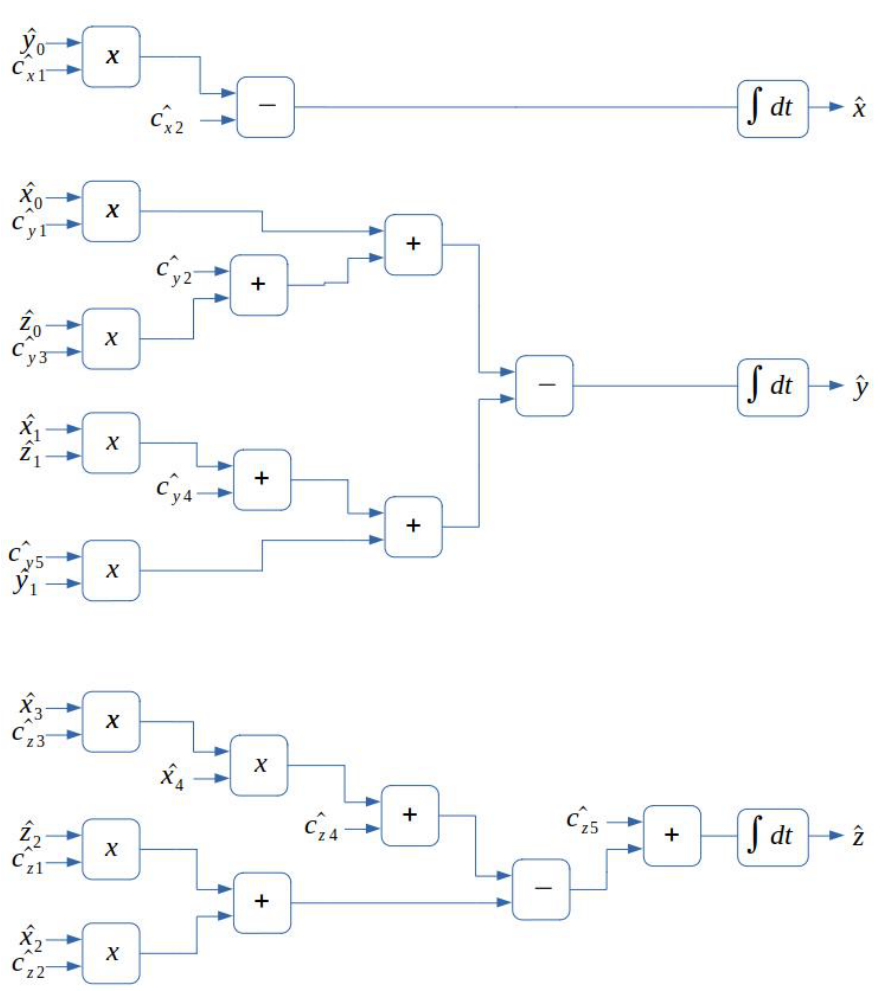
Figure 9. Implementation of the Shimizu-Morioka equations using SC. The subindex in the variables means a delay equivalent to the number used to decorrelate them. The constants c i are those corresponding to Equation